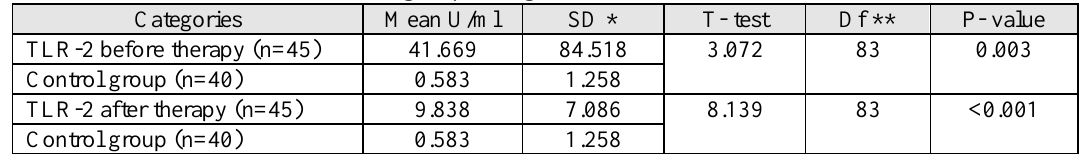
Table (1): Statistical comparison between study group before and after therapy with control group in regard to TLR-2.